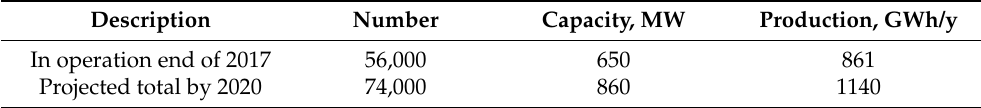
Table 5. Geothermal heat pumps in Poland